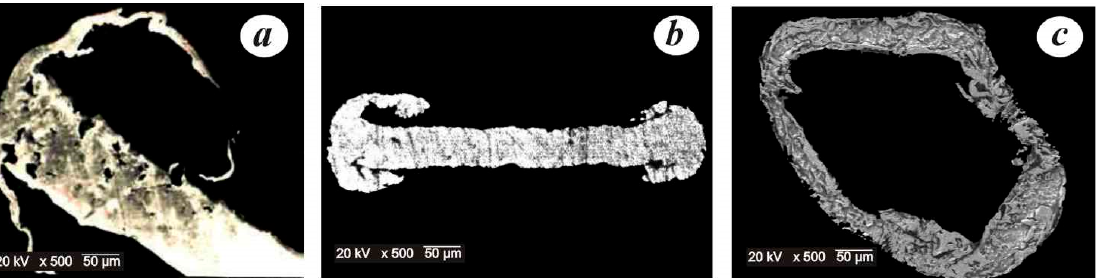
Figure 6. Internal structures of aeolian gold (cross section): ( а ) flake gold particle with a thin ridge along the edge and a recrystallized structure; ( b ) toroidal gold particle with fine-grained recrystallized structure; ( c ) spherical-hollow gold of high fineness 1000‰, the shell of the sphere is completely recrystallized.